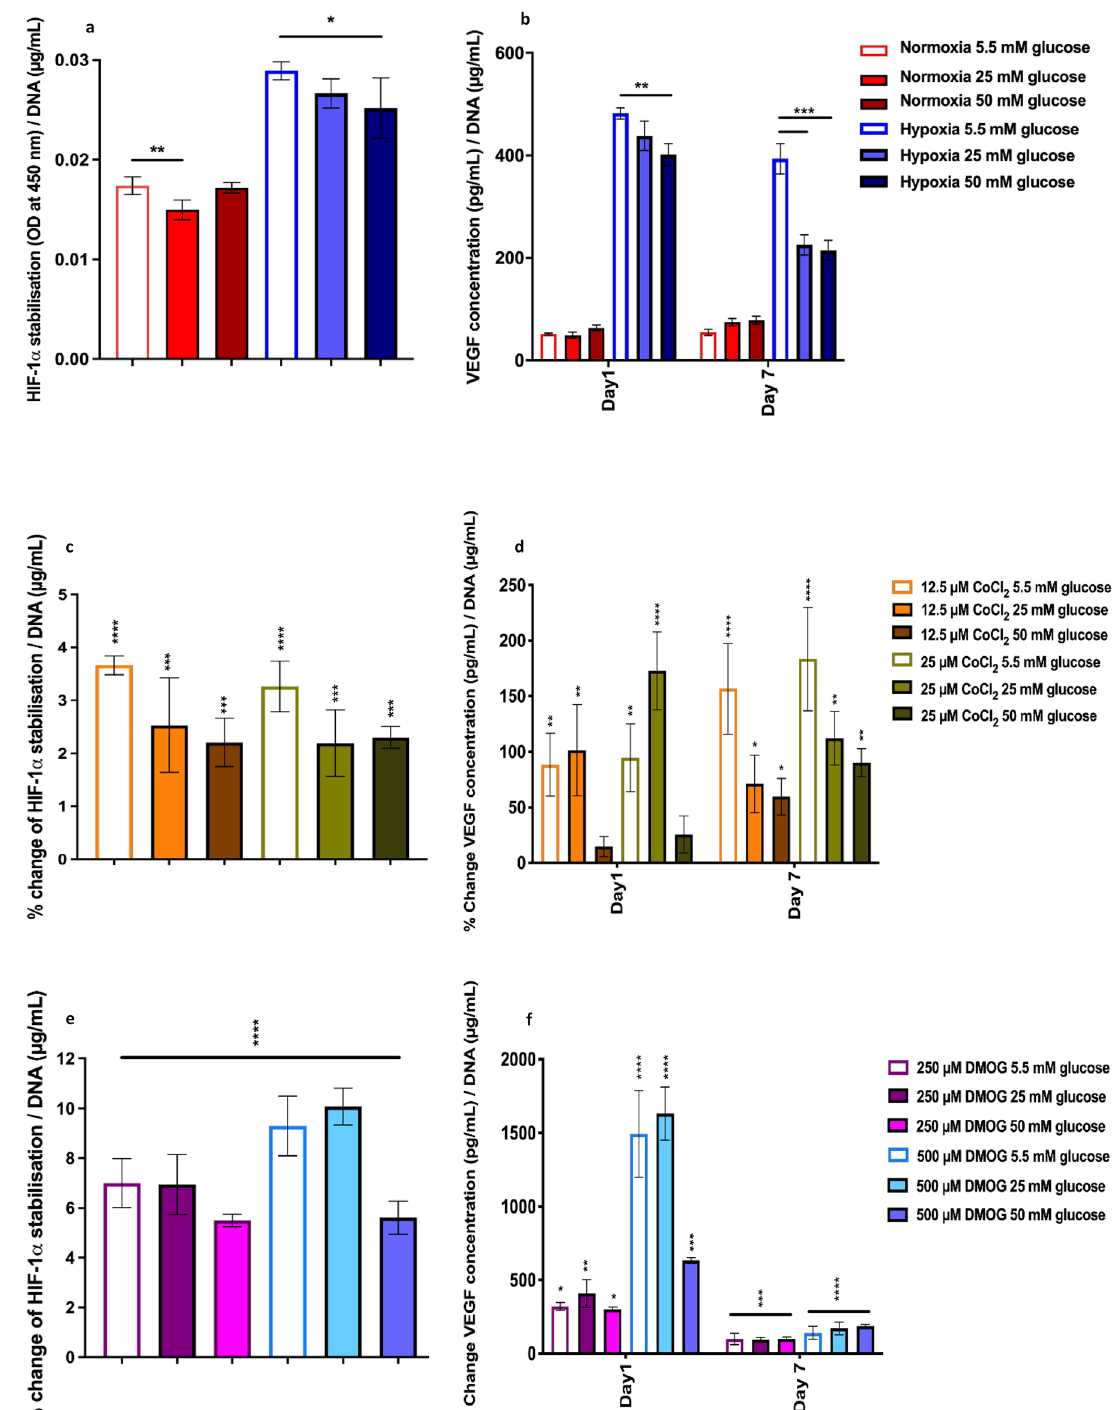
Figure 7. HIF-1α stabilisation on day 3 and VEGF response on day 1 and 7 of osteoblast to hypoxia and hypoxic mimetics CoCl 2 and DMOG in hyperglycaemic conditions. ( a ) Hyperglycaemia impaired HIF pathway and ( b ) decreased VEGF expression. ( c – f ) Both CoCl 2 and DMOG restored HIF-1α stabilisation and VEGF expression in hyperglycaemic conditions (percentage change compared corresponding glucose levels in atmospheric O 2 ). Error bars represent the SD from the mean values. *P ≤ 0.05; **P ≤ 0.01; ***P ≤ 0.001*; ****P ≤ 0.0001 (n =